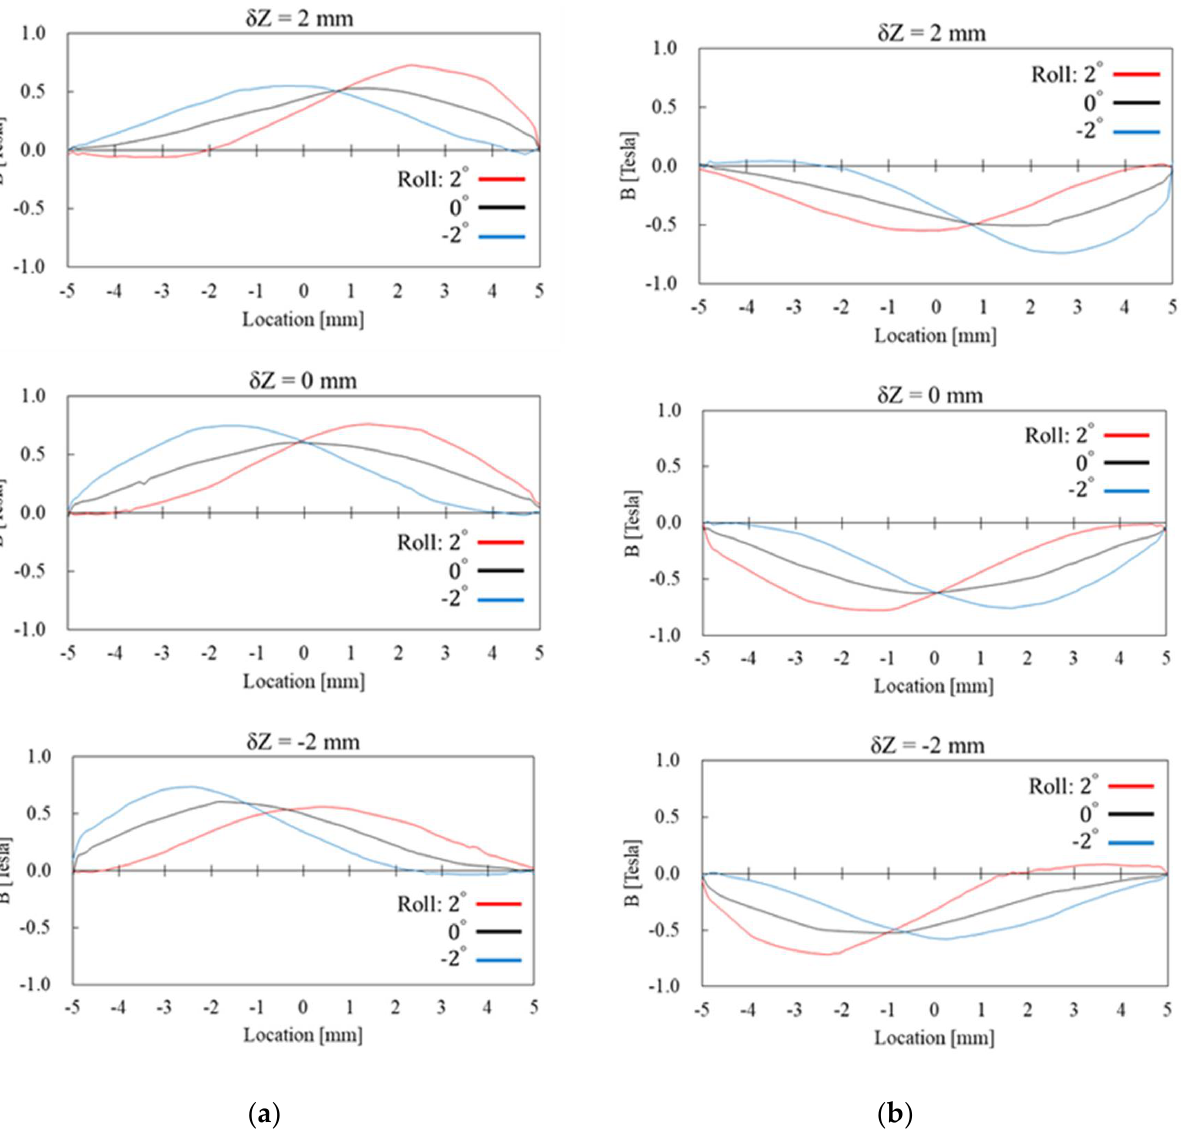
Figure 12. Simulation results of the axial magnetic flux density through the Wiegand wire with Y being set at ( a ) −0.1 mm and ( b ) 0.1 mm, respectively.